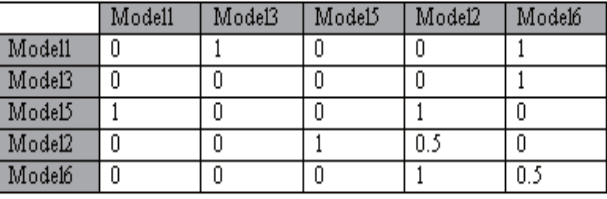
Fig. 7. Rearranged dependence matrix of variable flow model of Figure